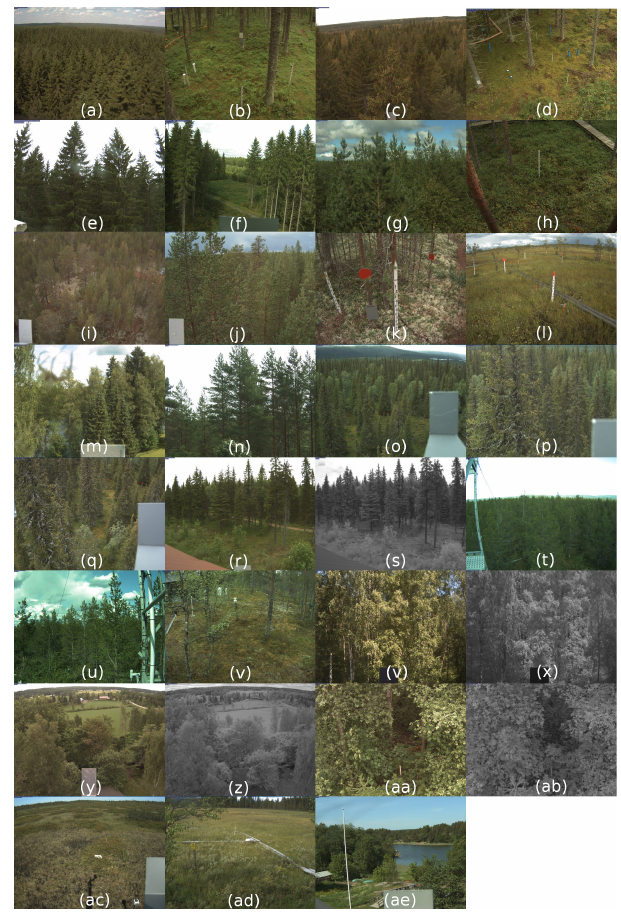
Figure 2. Camera views: MC100 (a) , MC101 (b) , MC102 (c) , MC103 (d) , MC104 (e) , MC105 (f) , MC106 (g) , MC107 (h) , MC108 (i) , MC109 (j) , MC110 (k) , MC111 (l) , MC112 (m) , MC113 (n) , MC114 (o) , MC115 (p) , MC116 (q) , MC117 (r) , MC118 (s) , MC119 (t) , MC120 (u) , MC121 (v) , MC122 (w) , MC123 (x) , MC124 (y) , MC125 (z) , MC126 (aa) , MC127 (ab) , MC128 (ac) , MC129 (ad) , MC130 (ae) . Abbreviations refer